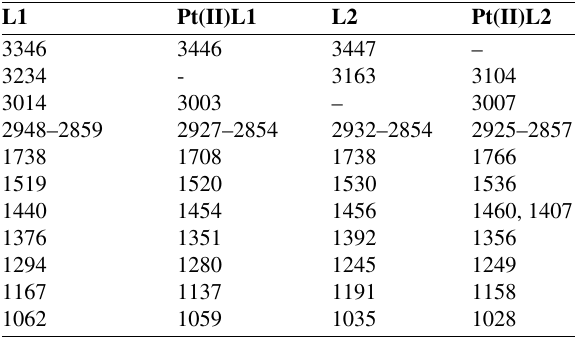
Table 1. Selected IR bands (cm –1 ) in KBr for the free ligand L1 and L2 and their Pt(II)